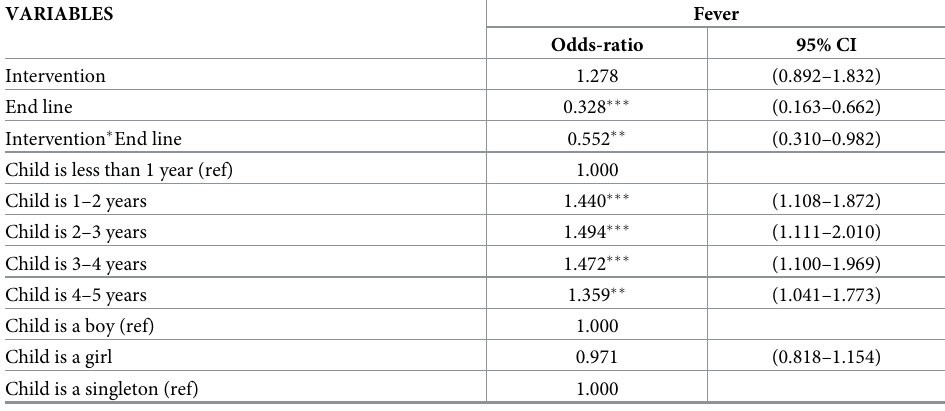
Table 3. The estimated effect of GEHIP on health system childhood morbidity